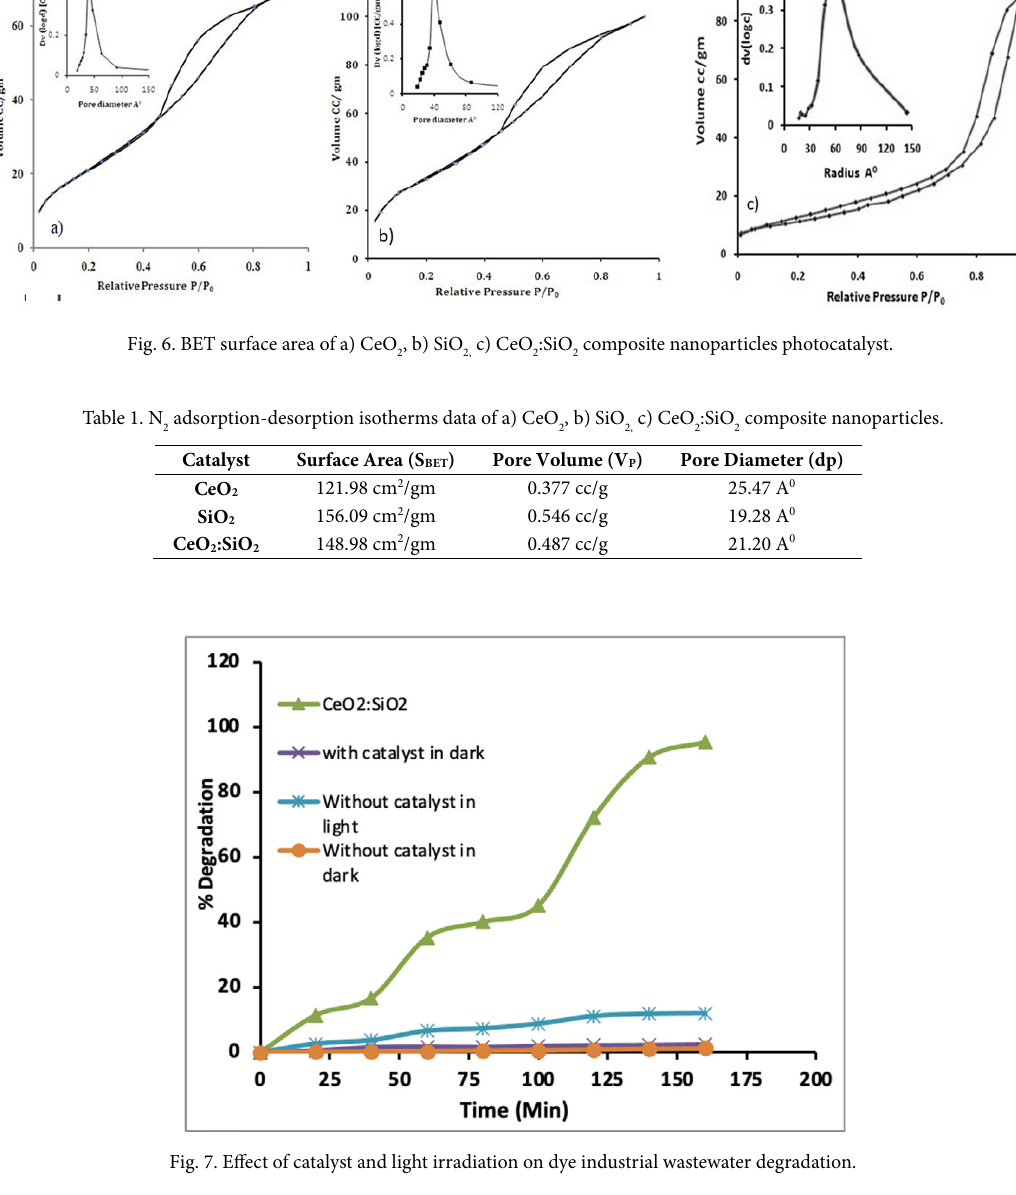
J. Water Environ. Nanotechnol., 6(4): 306-316 Autumn 2021